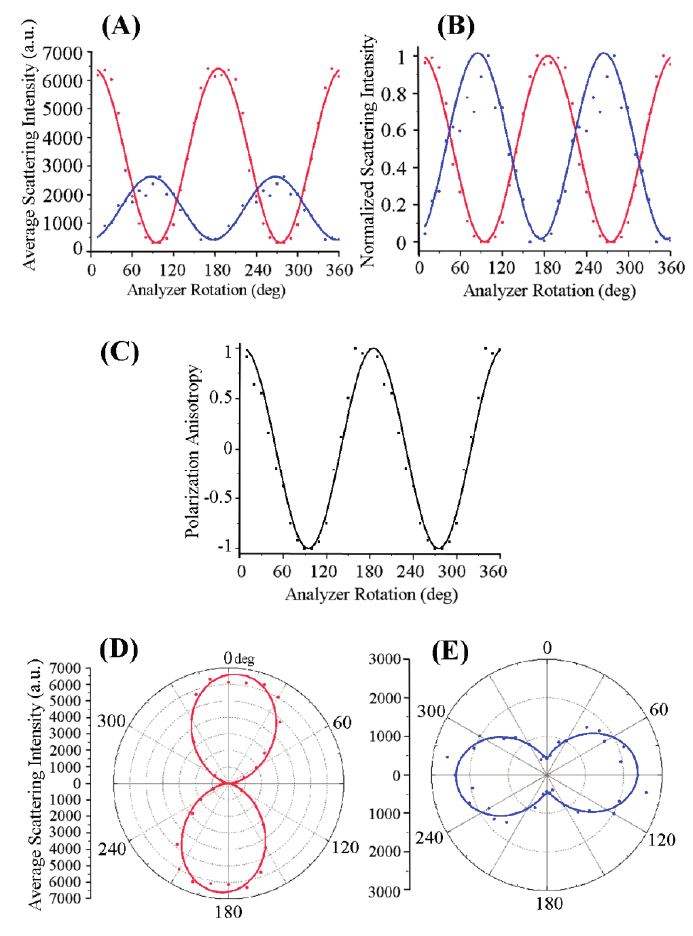
Figure 5. The NR position-dependent scattering signals under the two excitation conditions of E ║ and E ┴ are collected over the entire length of the ZnO NR ┴ and plotted against the analyzer rotation. Red and blue symbols in all graphs are experimental data when the excitation polarizations of E ║ and E ┴ are used, respectively. Lines represent curves fits for the corresponding set of data. ( A ) The position dependent scattering signal averaged over the entire length of the NR ┴ is plotted as a function of the analyzer angle. The overall scattering intensity from the same NR was much lower when E ┴ was used as excitation instead of E ║ while keeping the same exposure time of 10 ms. ( B ) The average scattering intensity was normalized with respect to the highest intensity values measured at each excitation condition and graphed as a function of analyzer rotation. ( C ) Polarization anisotropy values calculated from the data shown in (B) follow a cos 2 θ dependence on the analyzer angle, θ . ( D and E ) Polar plots of average scattering intensities of the ZnO NR ┴ under (D) E ║ and (E) E ┴ excitation are